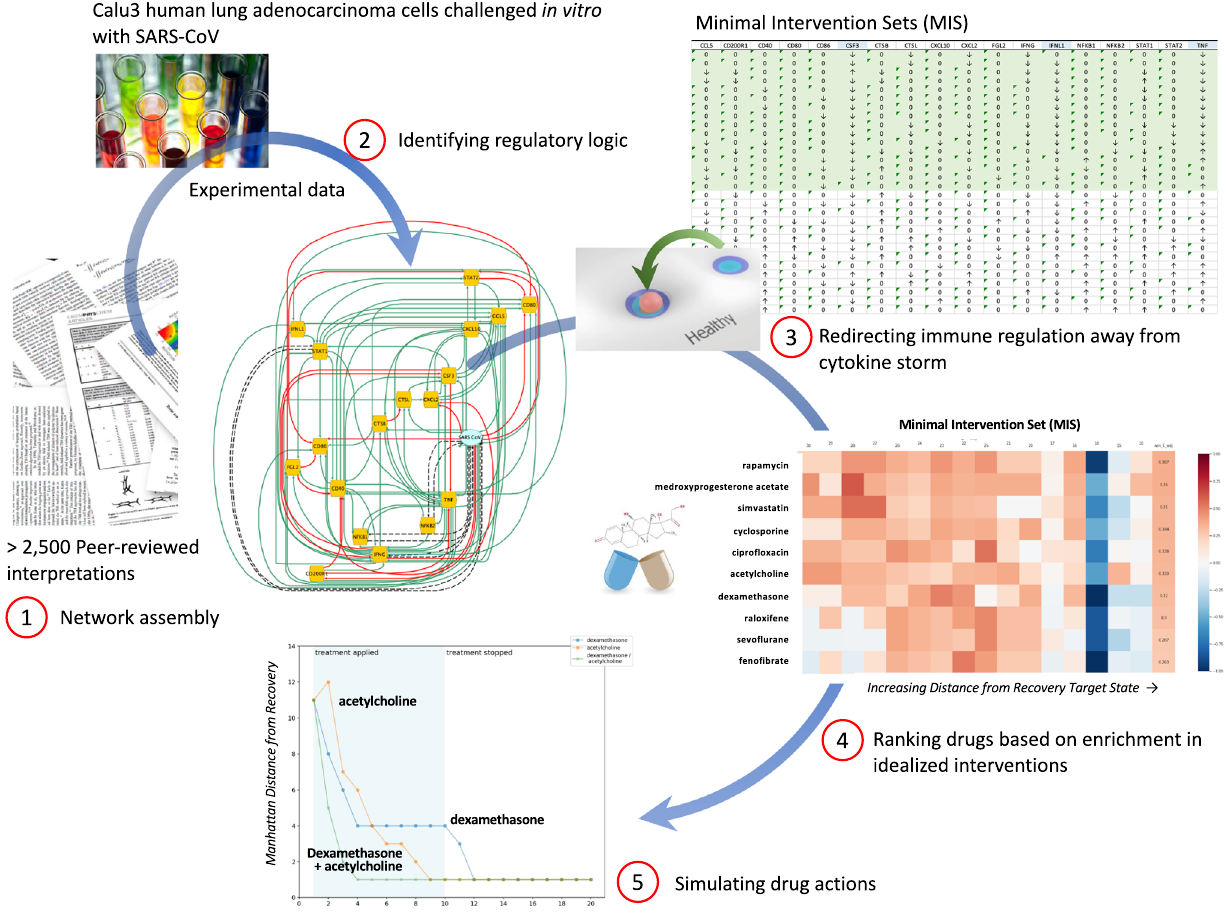
Fig. 8 A regulatory network informed process for ranking candidate drugs. The computational work fl ow for identifying and ranking drugs available for repurposing to COVID-induced ARDS consists of several sequential steps, namely (1) a regulatory network is assembled that links the biological mediators of interest through documented regulatory interactions extracted by text-mining of the peer-reviewed literature, (2) sets of logical parameters capturing receptor af fi nity effects and context-speci fi c regulatory responses are identi fi ed that support adherence to available data using a Constraint Satisfaction approach, (3) the resulting sets of competing dynamic network models are used to identify sets of target nodes that if manipulated concurrently would succeed in disrupting a persistent pathology like ARDS to restore normal immune regulation, (4) candidate compounds are then ranked based on how well and how speci fi cally they support one or several of these idealized interventions. Finally, (5) the actions of top-ranking drugs and drug combinations are simulated to verify expected response